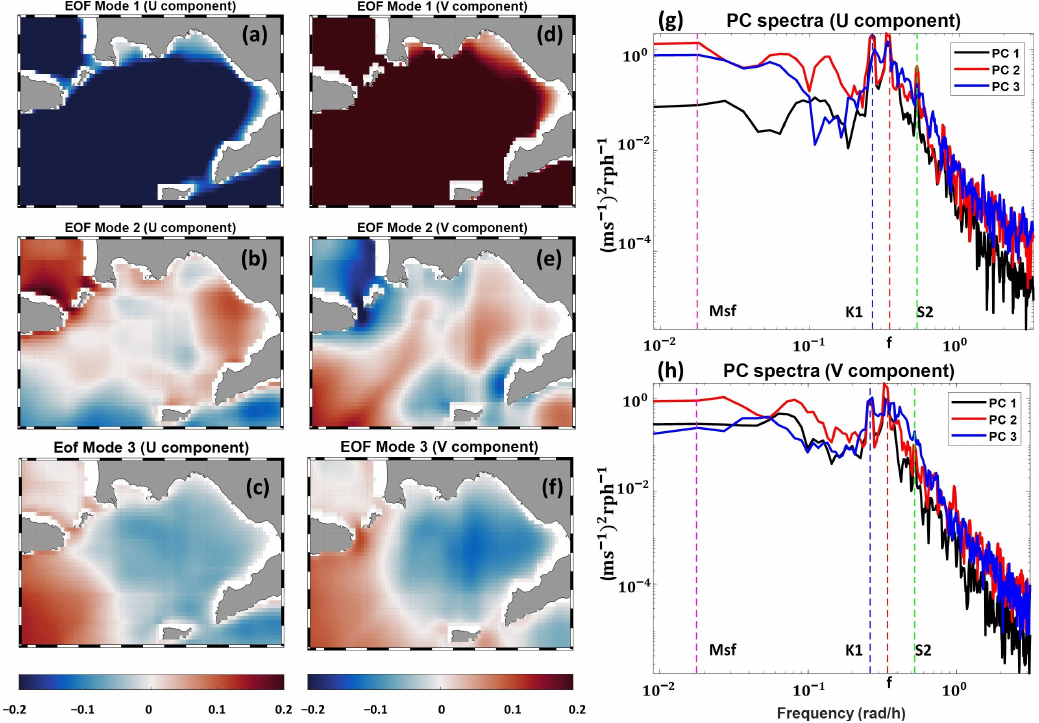
Figure 16. Spatial pattern of 3 EOF modes ( a ‐ f ) for the simulated surface current field in June 2016. Frequency spectra of the expansion coefficient associated with the 3 principal modes for the zonal ( g ) and meridional ( h ) components.